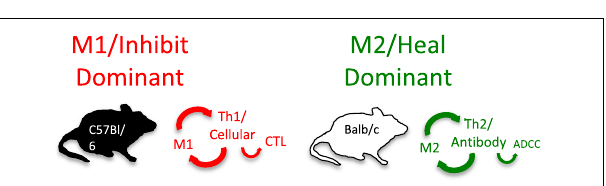
FIGURE 7 | Macrophages from C57Bl/6 mice make M1-dominant (NO) responses while Balb/c are M2-dominant (ornithine) . M1- or M2-dominant responses stimulate Th1- or Th2-type responses that can further amplify cellular/CTL and M1, or antibody-type and M2 responses. From Ref. (1) with permission from S. Karger AG,